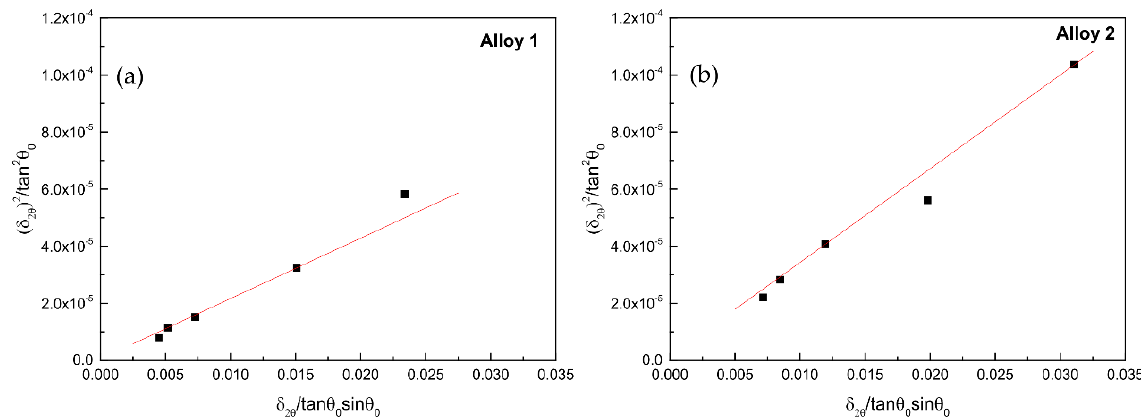
Figure 4. Integral breadth analysis to calculate the coherent diffraction zone size and lattice strain from XRD data.